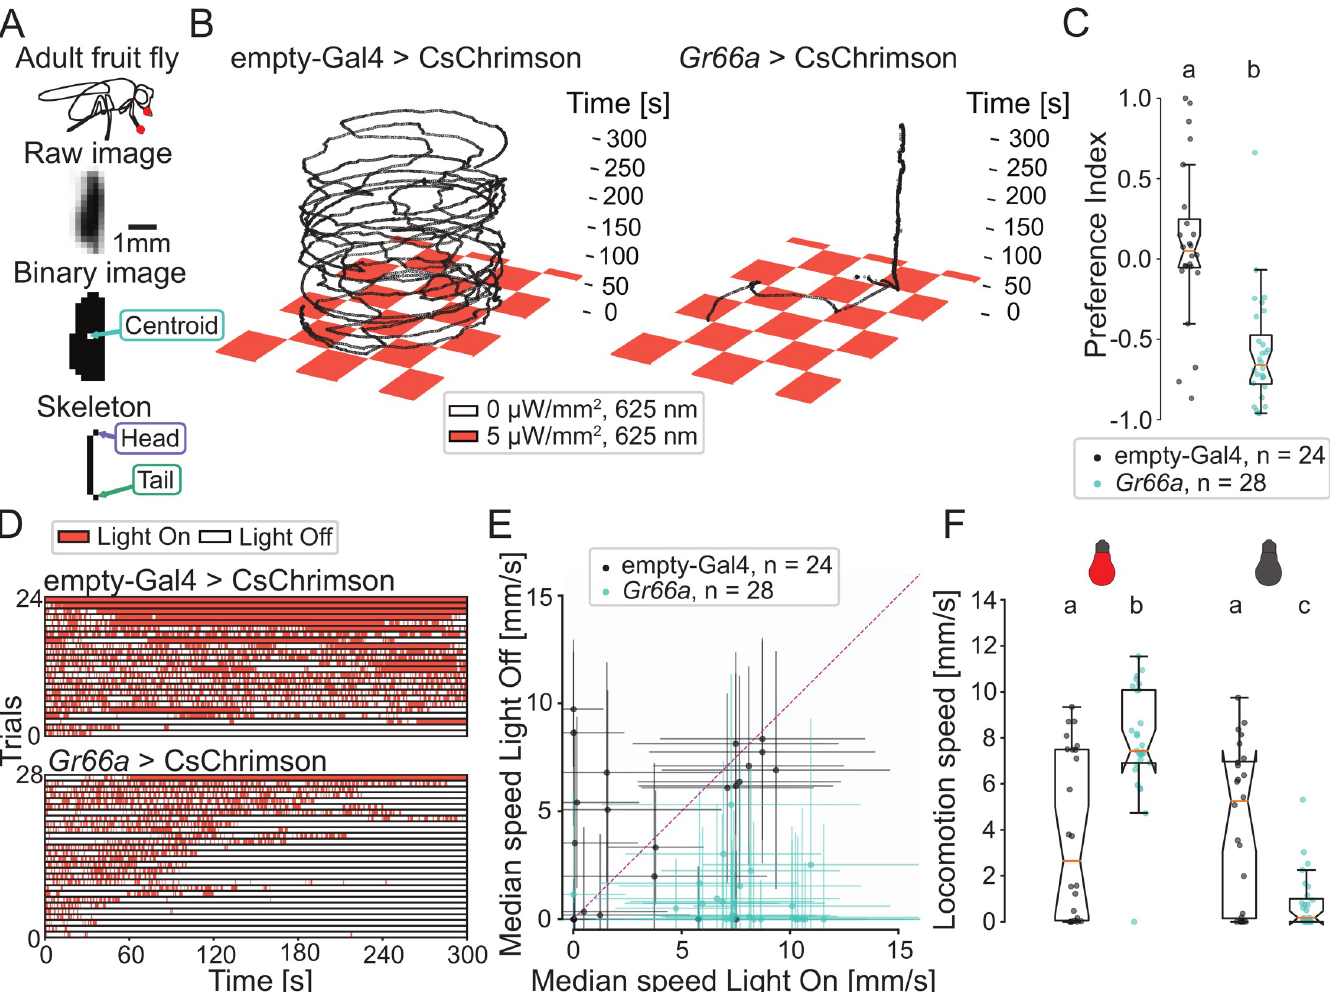
Fig 3. Adult fruit flies avoid activation of bitter-sensing neurons by modulating their locomotion speed. (A) Adult Drosophila expressing CsChrimson in Gr66a bitter-sensing neurons (red circles). Illustration of the identification of different body parts of a moving fly by PiVR. (B) Illustrative trajectories of flies in a virtual checkerboard pattern and the corresponding ethogram. Flies were behaving in a petri dish. (D) The ethogram reports the time spent by individual animals (rows) in the dark (white) and lit (red) squares. Panel C displays a quantification of the avoidance of virtual bitter taste through a preference index: PI ¼ T ON (cid:0) T OFF spent on the ON or OFF quadrants (Mann–Whitney U test, p < 0.001). (E) Median locomotion speeds of individual animals as a function of the exposure to light. (F) Quantification of locomotion speeds across experimental conditions (Dunn’s multiple comparisons test, different letters indicate at least p < 0.01). Statistical procedures are detailed in the Methods section. Statistical significances are indicated with lowercase letters. All data used to create this figure are available from https://doi.org/10. 25349/D9ZK50. Gr66a, gustatory receptor 66a; PiVR, Raspberry Pi Virtual Reality.